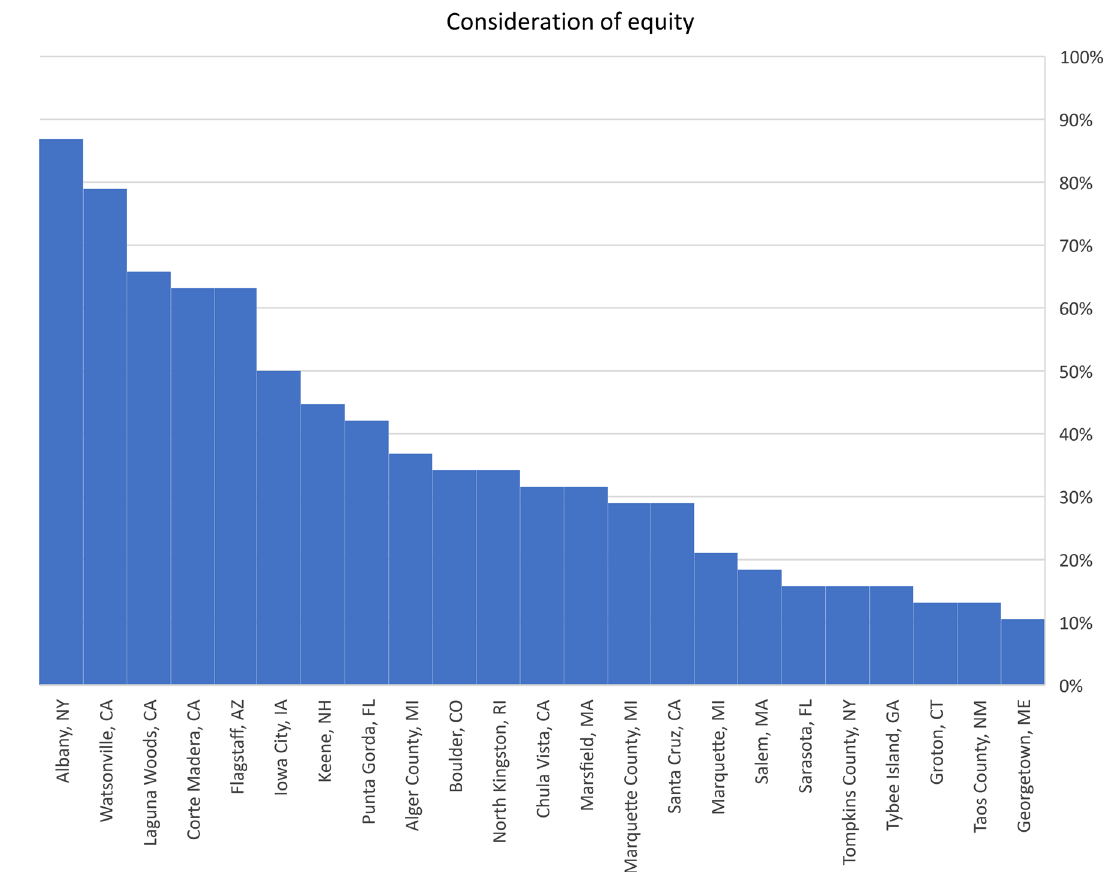
Fig. 4 Consideration of equity in climate adaptation